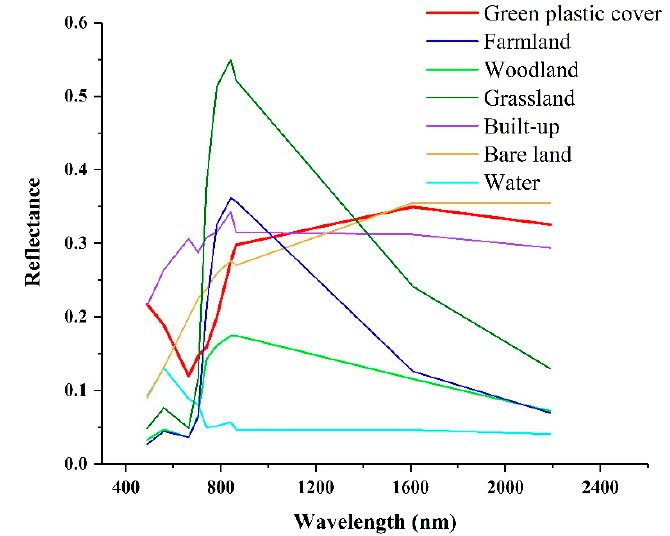
Figure 4. Comparison of spectral characteristics between GPC and other land cover types.